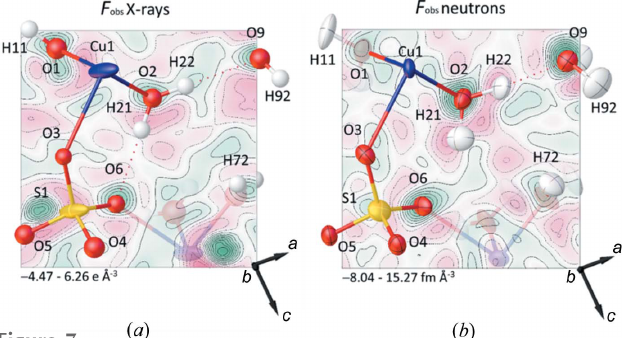
Figure 7 Slices in the O9—O2—O6 plane of the observed ( a ) electron and ( b ) nuclear density maps of copper sulfate pentahydrate at 0.71 GPa. Only the atoms in or above the iso-surface are labelled for clarity. Images were generated in Olex2 (Dolomanov et al. , 2009). Positive and negative densities are shown in green and red,